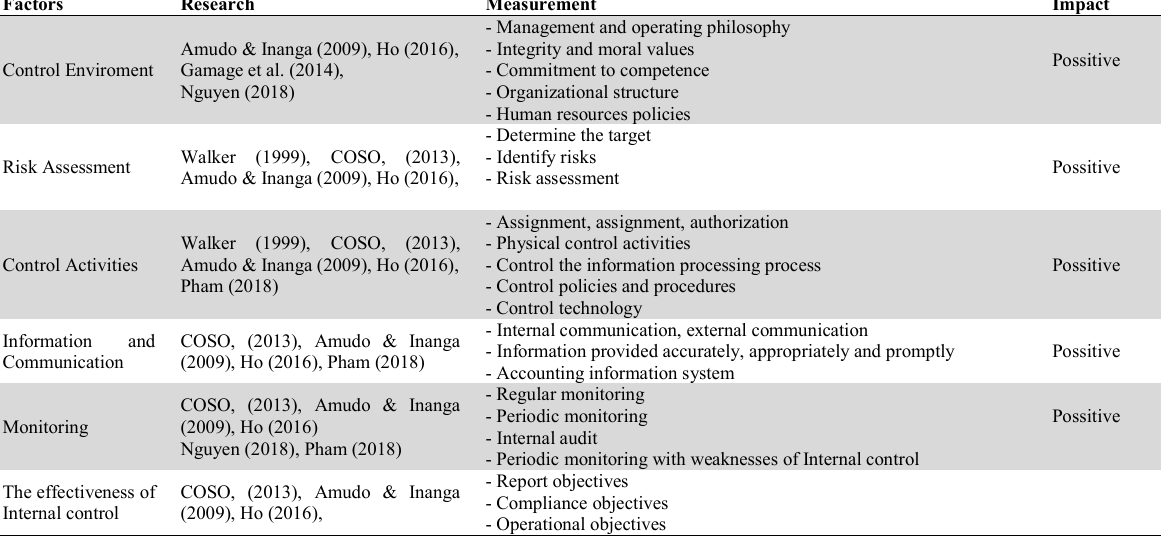
The summary of the factors influencing on the effectiveness of internal control